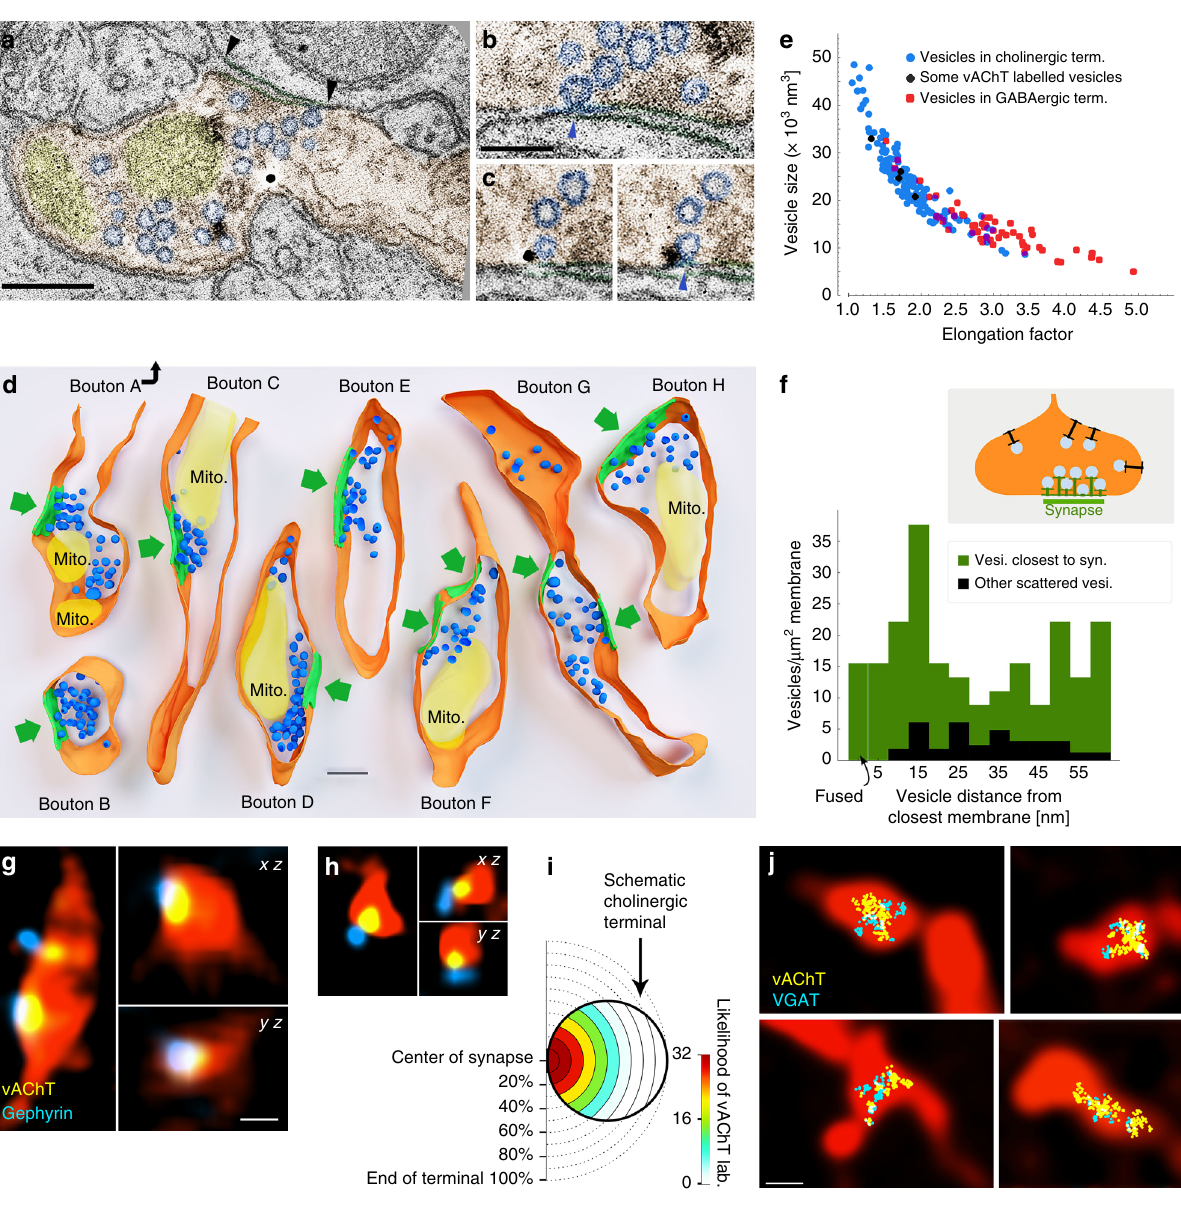
Fig. 4 Separate vesicular release of acetylcholine and GABA from the same synaptic active zones. a – c About 0.5 nm-thick virtual sections from electron tomographic reconstructions of cholinergic terminals. Terminal is orange, mitochondria are yellow, synaptic vesicles are blue. Black arrowheads point to the edges of the synapse. Scale bar is 200 nm. b Active zone is enlarged from a . The omega-shaped vesicle is being fused with the terminal membrane (blue arrowhead). c Two serial virtual sections showing a portion of the active zone of another terminal. A fused synaptic vesicle (blue arrowhead) is labelled for vesicular acetylcholine transporter (black immunogold particle). Scale bar for b and c is 100 nm. d Three-dimensional models of reconstructed terminals. Terminal membranes are orange, mitochondria are yellow, synaptic vesicles are blue and synapses are green. Green arrows point to the synapses. Scale bar is 200 nm. The association of the vesicle pools to the active zones is evident. e Scatterplot shows the relationship of vesicle size (volume) and elongation factor in the sampled vesicles. Vesicles in the cholinergic terminals had a broader size-distribution than vesicles of purely GABAergic terminals, which were smaller and more elongated (Supplementary Note 4). Some vesicles (black markers) could be identi fi ed as vAChT-positive because immunogold particles clearly labelled them. f The density of the vesicles within a 60-nm-wide band from the membrane is plotted as a function of distance from the terminal membrane at synaptic (green) and extra-synaptic (black) areas. Vesicle density was 6.5 times higher (in the fi rst 60 nm from the membrane) in the synaptic active zone than extrasynaptically ( n = 183 vesicles from 8 terminals in 2 mice). Docked (closer to the membrane than 5 nm) or fused (undergoing exocytotic fusion) vesicles were absent extrasynaptically, but were present in the active zones. g , h vAChT labelling was con fi ned to synaptic active zones in cholinergic fi bres. CLSM images show terminals of virus-traced septo-hippocampal fi bres (red pseudocolor) containing vAChT- positive vesicle pools (yellow), localised to the synaptic active zones that are identi fi ed by gephyrin labelling (blue). Scale bar is 500 nm for g and h . i Scale- free analysis con fi rms that the likelihood of vAChT labelling is the highest at the synaptic active zones ( n = 32 synapses, 2 mice). j Correlated CLSM- STORM super-resolution microscopy images show that vAChT (yellow) and vGAT (cyan) vesicle pools are overlapping and are con fi ned to small portions within AAV-eYFP virus-traced septo-hippocampal fi bres (red